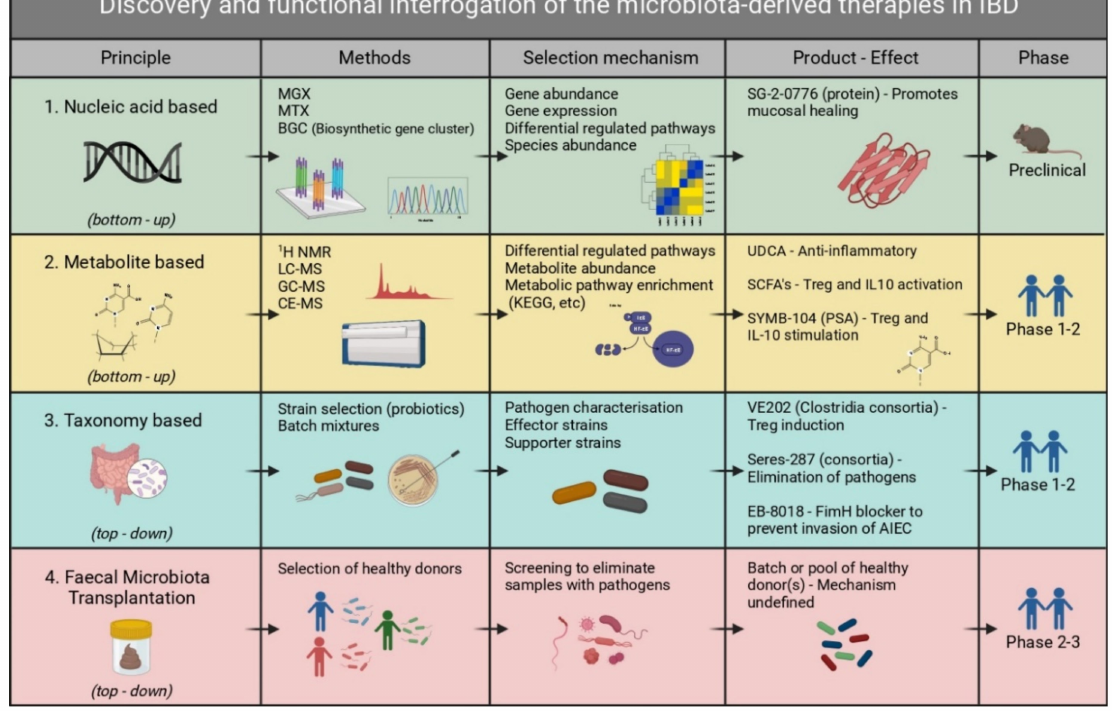
Figure 1. Discovery and functional interrogation of microbiota-derived drug candidates in IBD. Methods for discovery of microbe-derived drugs for IBD can broadly be divided into bottom-up (sequence or metabolite based) and top-down (taxonomy or FMT based). A bottom-up approach refers to starting with the basic building blocks or individual components of the microbiome, i.e., metabolites or genes, working your way up through screening these many components, and identifying their function. A top-down approach starts with a complex mixture, i.e., the whole microbiota or part thereof, followed by narrowing down functional components by positive selection on sub-fractions of the pool. For nucleic acid- based methods, the MGX (metagenomics) and MTX (metatranscriptomics) technologies provide information about the relative abundance of species, genes, and transcripts. Metabolite-based methods apply analytical techniques such as MS to discover metabolites that are differently abundant in IBD. Taxonomy-based studies use a gnotobiotic approach that starts from complex microbiota samples and narrows these down to effector strains, after which their mechanism of action is investigated. In addition, drugs that are designed to reverse dysbiosis also fall in this category. Therapies based on FMT aim to identify donors with microbial communities that induce remission upon transplantation, without delineating specific mechanisms or factors. Whereas most nucleic acid- and metabolite-based drugs are in the preclinical phase, several taxonomy- and FMT-based drugs have passed the first clinical trial stage. FMT, fecal microbiota transplantation; MGX, metagenomics; MTX, metatranscriptomics; MS, mass spectrometry; LC-MS, liquid chromatography-mass spectrometry; GC-MS, gas chromatography-mass spectrometry; CE-MS, capillary electrophoresis-mass spectrometry; KEGG, Kyoto Encyclopedia of Genes and Genomes; PSA, polysaccharide A; UDCA, ursodeoxycholic acid. Included in the product effect column are several examples of microbe-derived drugs for IBD in a preclinical or clinical trial phase. Created with